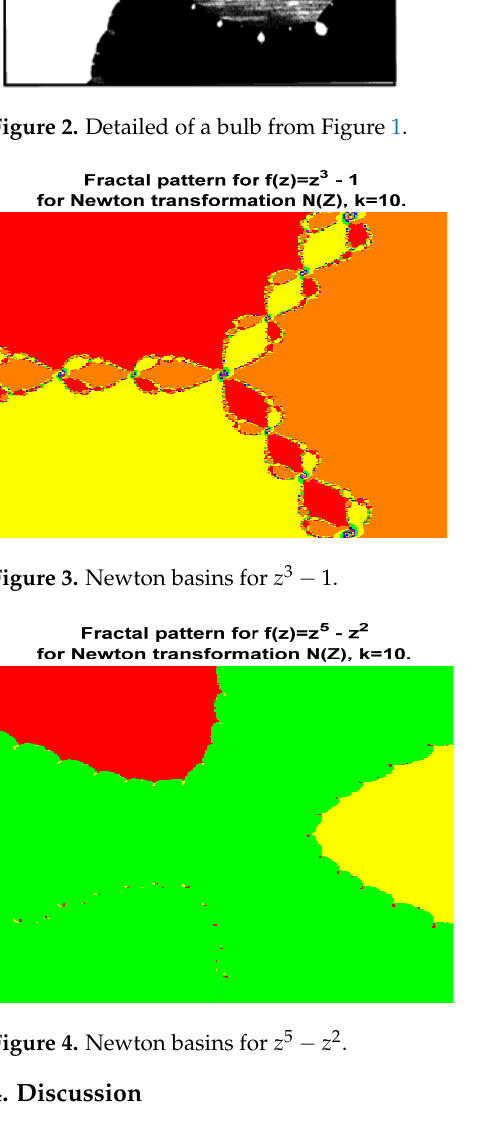
Figure 4 Newton basins for